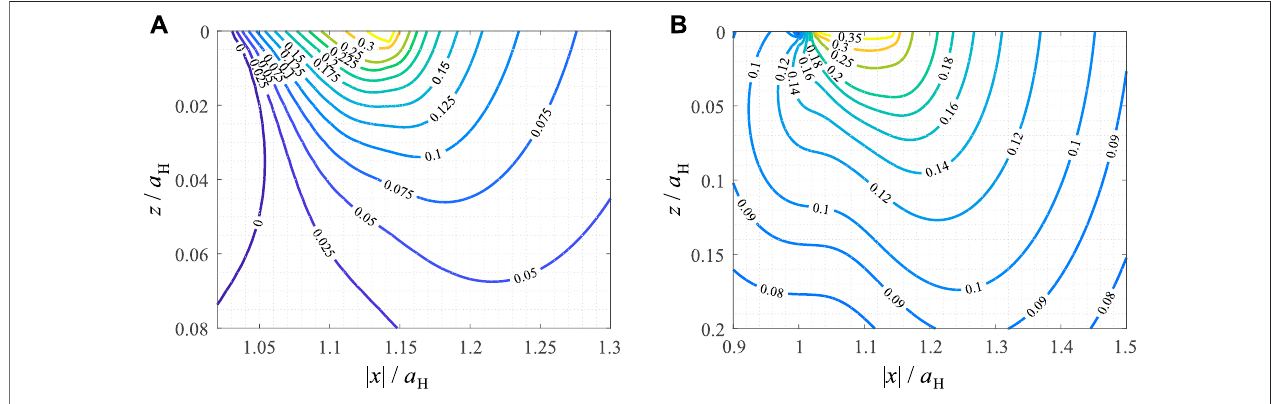
FIGURE 6 | Contour line diagrams of critical plane fatigue crack initiation criteria, normalized for their characteristic scales, in the loading plane for a partial slip axisymmetric truncated parabolic contact under oscillating tangential load. (A) Smith-Watson-Topper parameter (B) Findley